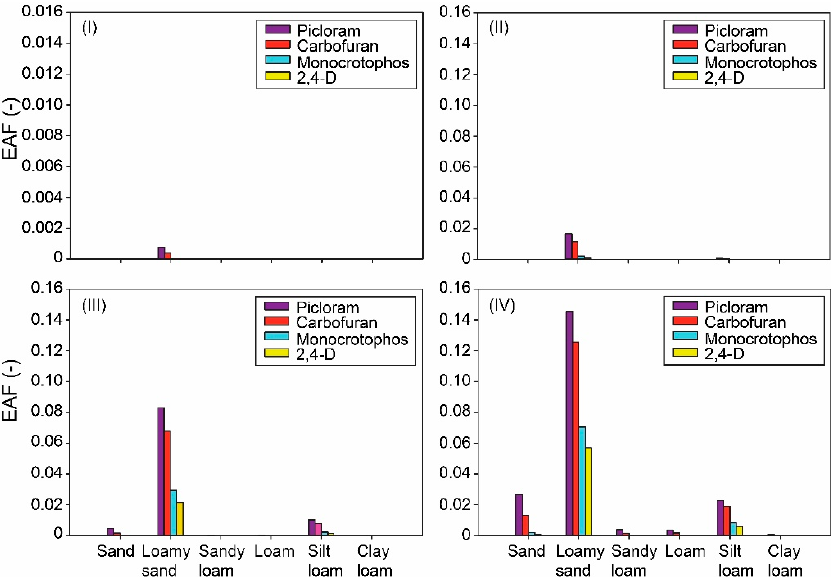
Figure 8. Effect of soil texture on leaching potential of Picloram, Carbofuran, Monocrotophos, and 2,4-D in Jazan watershed as assessed by EAF index model under four leaching potential scenarios: low, 0.0003 m d − 1 (I); medium, 0.0005 m d − 1 (II); high, 0.001 m d − 1 (III); and very high recharge rate, 0.002 m d − 1 (IV).